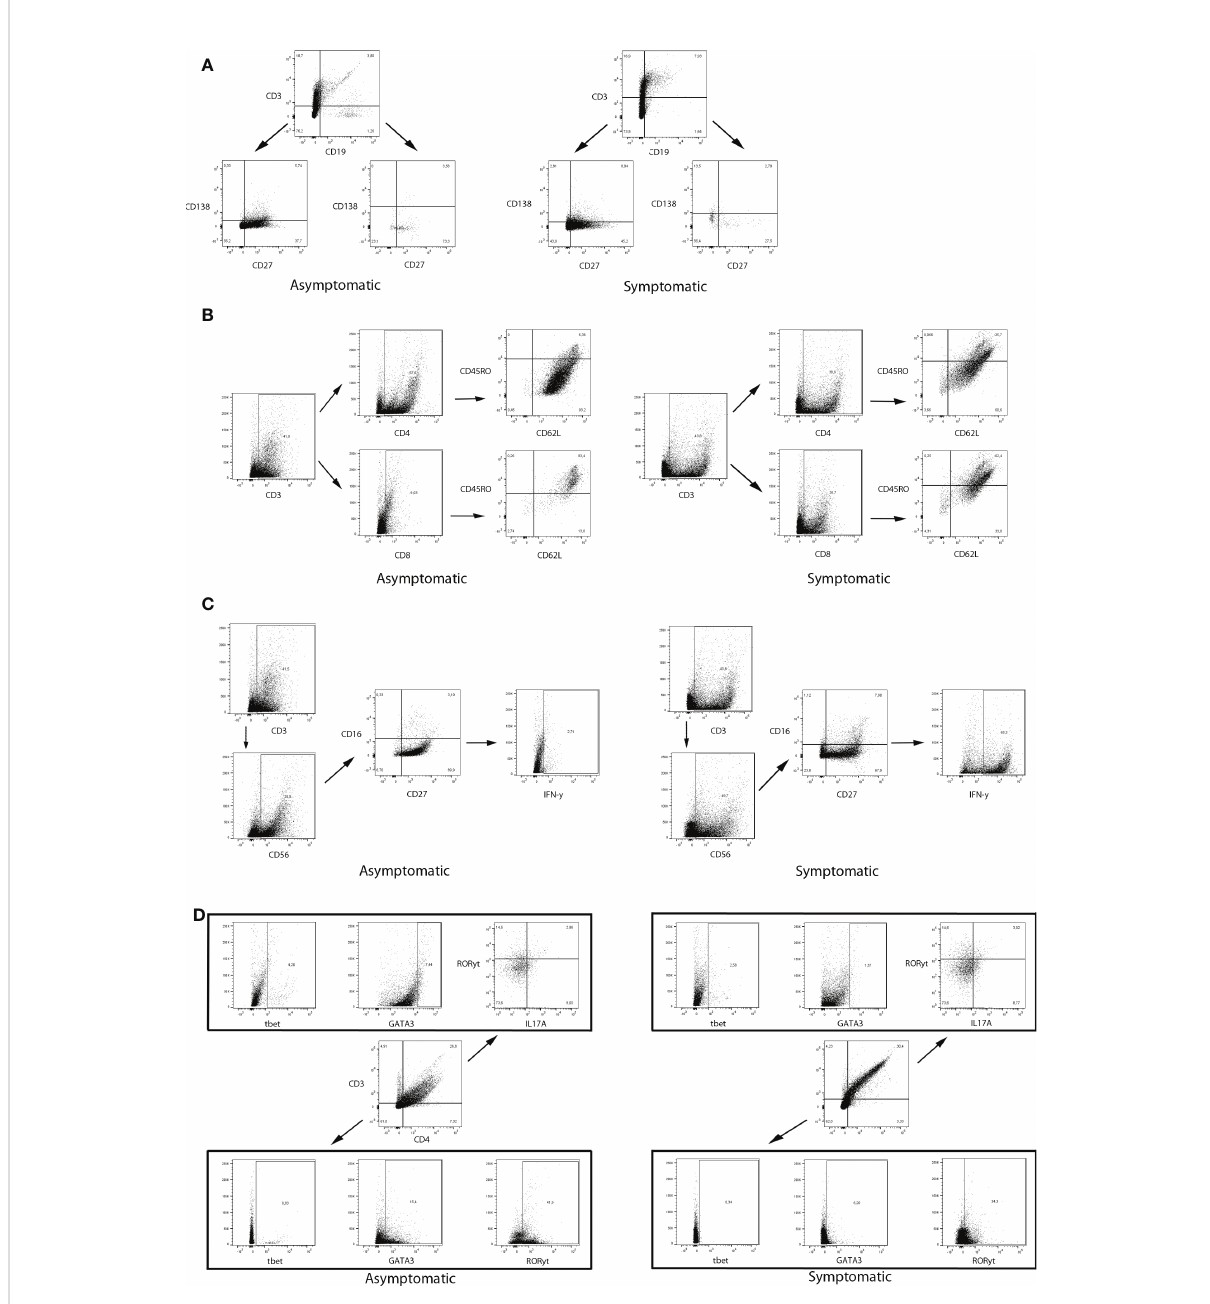
FIGURE 5 Gate strategies and representative dot plot graphs from fl ow cytometry data of two women (Asymptomatic number 7 and Symptomatic number 4). (A) CD3 - CD19 - and CD3 - CD19 + cells were gated for CD138 and CD27 analyzis. (B) CD3 + cells were further evaluated for CD4 or CD8. CD3 + CD4 + and CD3 + CD8 + cells were gated for CD45RO and CD62L analyzis. (C) CD3 - cells were evaluated for CD56. Both CD56 bright and CD56 dim were further analyzed for CD16 and CD27 expression. CD3 - CD56 bright CD16 - CD27 + cells were evaluated for IFN- g analyzis. (D) CD3 + CD4 + and CD3 - CD4 - were evaluated for tbet, GATA3, and ROR g t. CD3 + CD4 + ROR g t + were also analyzed for